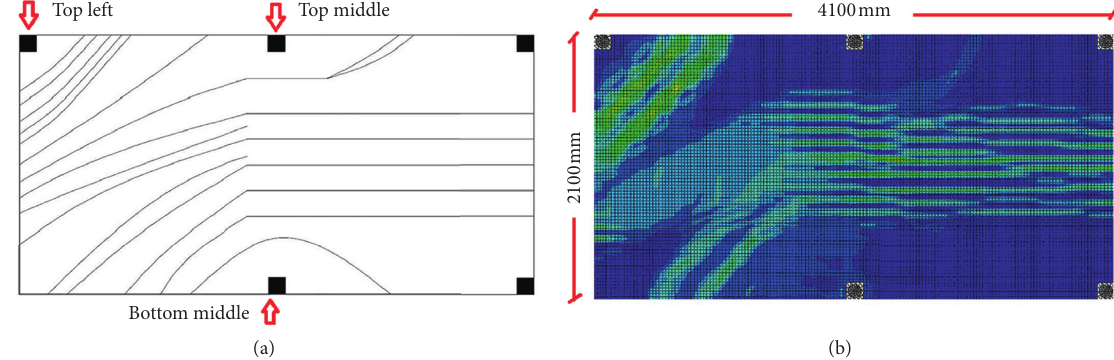
Figure 4: Crack on bottom surface of slab at the end of loading: schematic cracks based on findings of the reference laboratory model (a) and numerical model prediction using plastic strain (b).